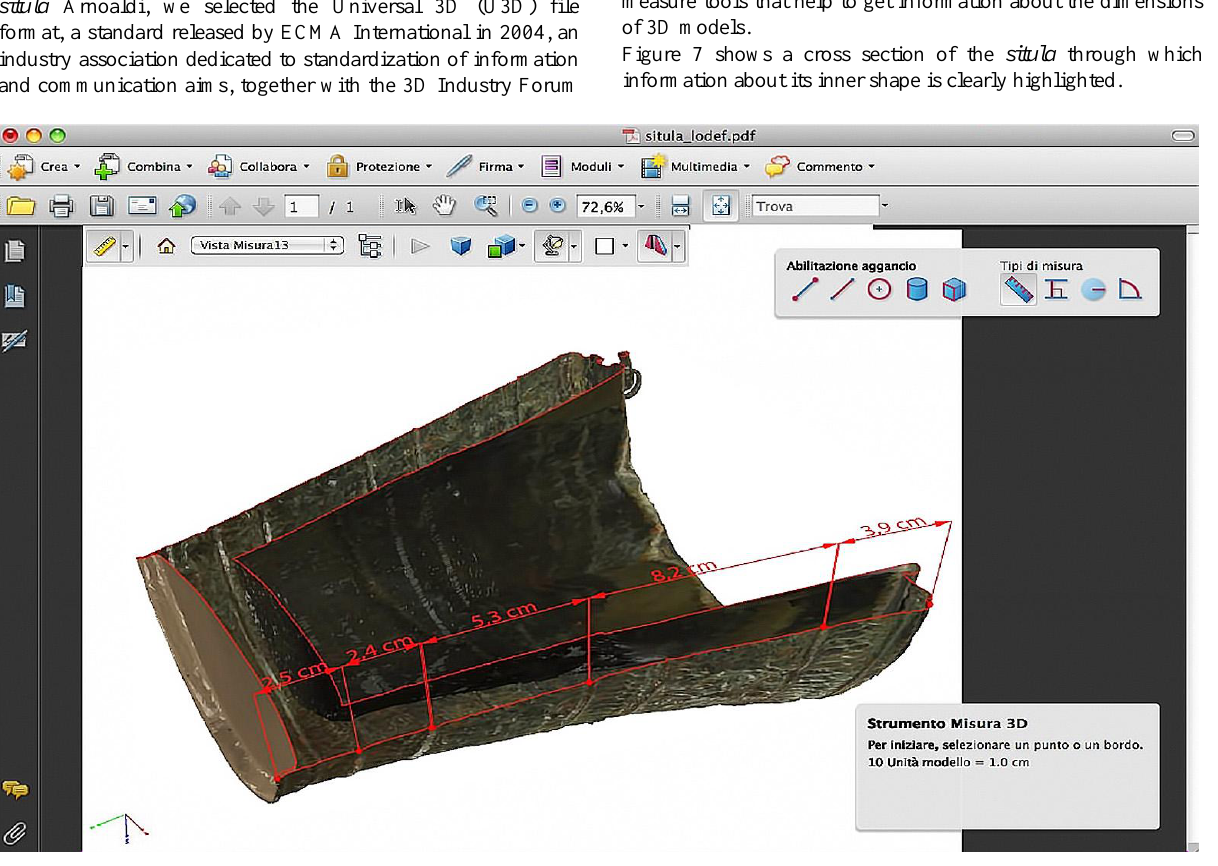
Figure 7. Exploring the situla through cross sections: an interactive U3D model embedded in 3D PDF can be easily visualized from different points of view and shaded using different light source in order to optimize contrast and better evaluate